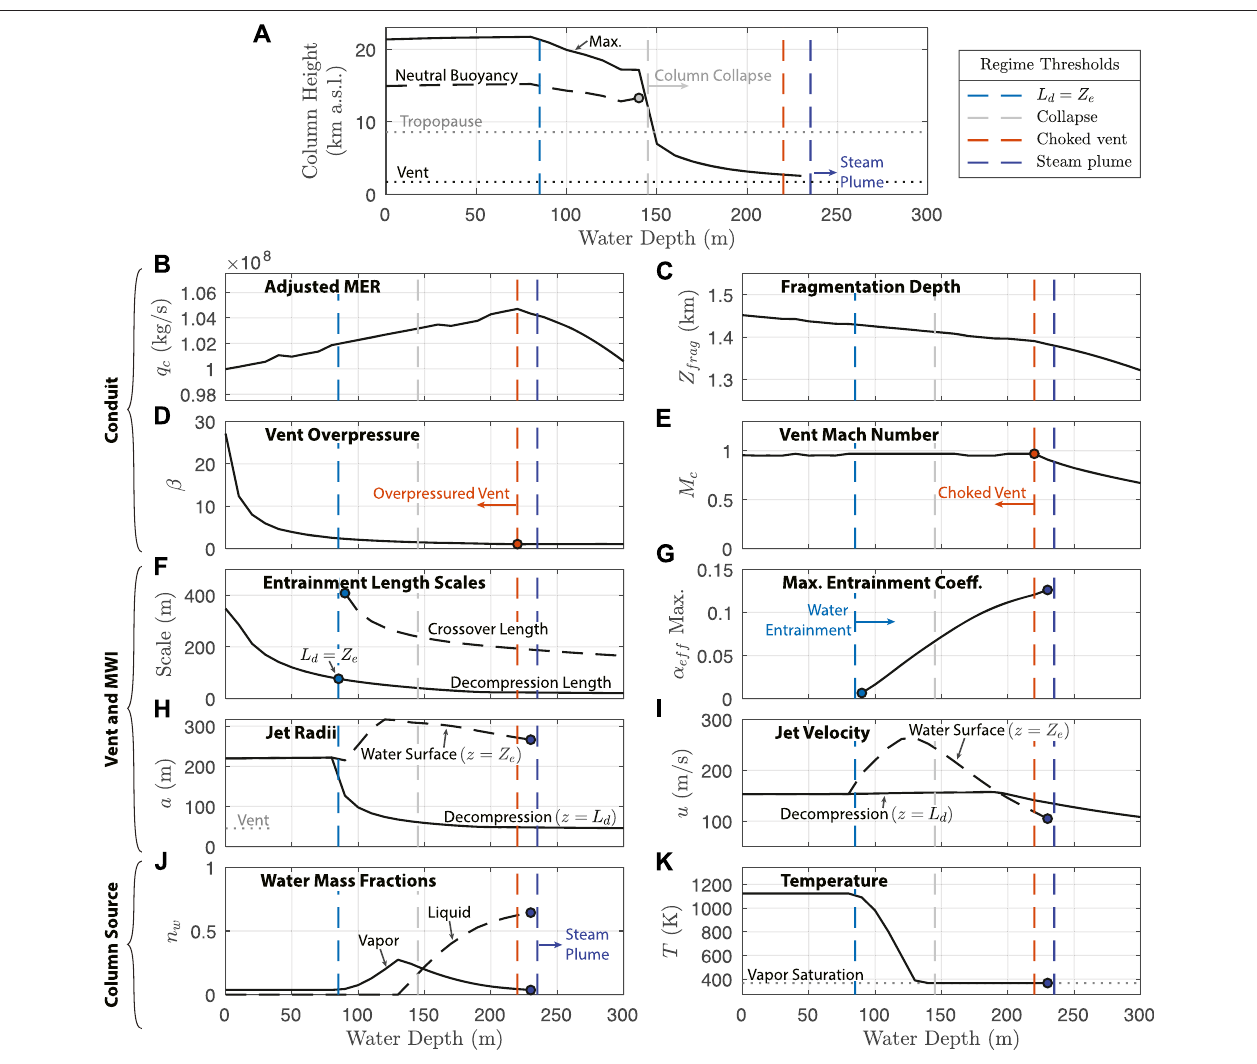
FIGURE 8 | Output of the coupled model (conduit, vent, and column) Reference scenario for Q 0 = 10 8 kg/s and a range of water depths. Behavior thresholds for decompression length, column collapse, vent choking, and steam plumes corresponding to regimes in Figure 9A are marked with vertical dashed lines. (A) Eruption columnmaximumheightandneutralbuoyancyheightabovesealevel,shownwithventandtropopausealtitude.Conduitresults: (B) adjustedconduitMER q c ; (C) depth offragmentationsurface;vent (D) overpressure β and (E) Machnumber M .MWImodelresults: (F) decompression L d andcrossover L X lengthscales; (G) maximum valueoftheentrainment coef fi cient inthewaterlayer; (H) radius ofthevent and jetafter initial decompression (at z = L d ) and at thewatersurface( z = Z e ) (J) velocity ofthe jet after initial decompression (at z = L d ) and at the water surface ( z = Z e ). Column source conditions: (J) vapor and liquid water mass fractions (K) bulk mixture